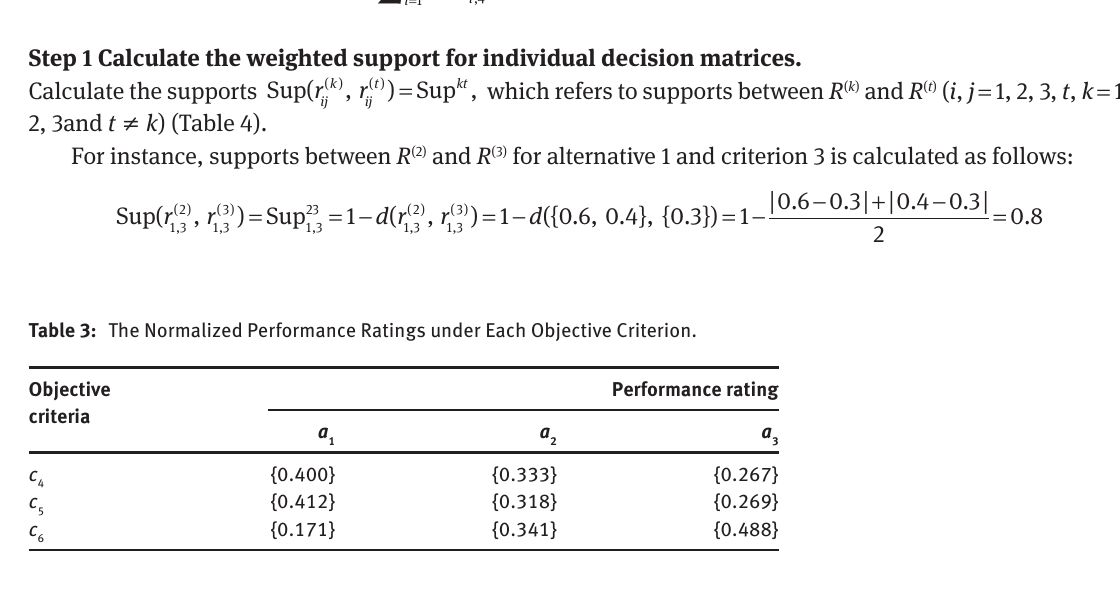
Table 3. For instance, for alternative 1 and criterion 4 normalized value is calculated as follows: